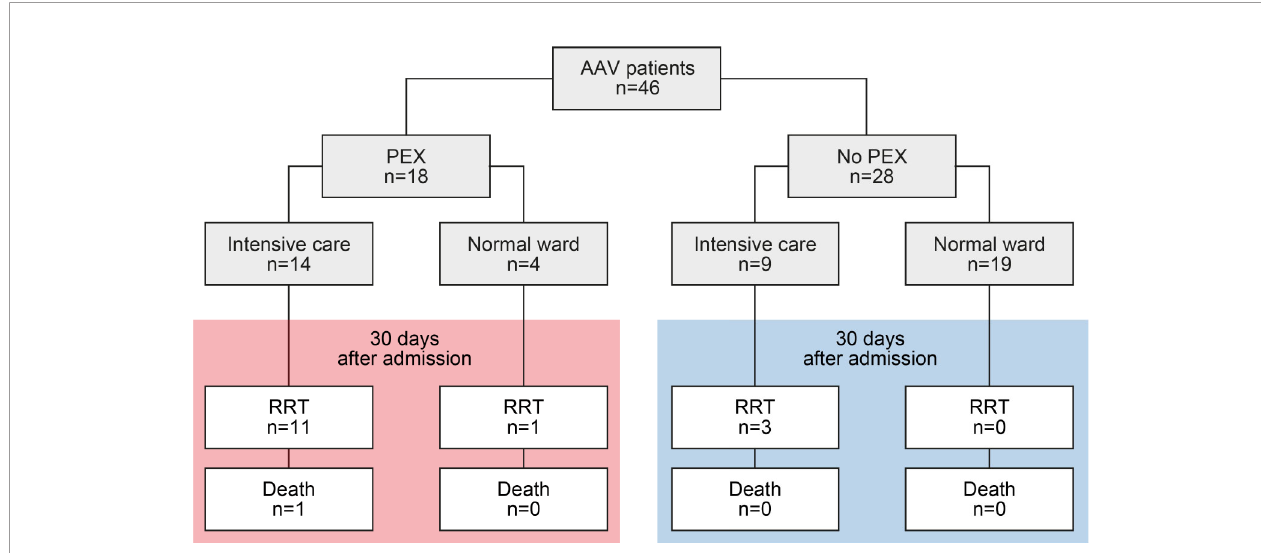
FIGURE 1 | Total patient cohort of severe AAV. STROBE fl ow chart of patient disposition, RRT was performed intermittently in all cases. AAV, ANCA-associated vasculitis; STROBE, Strengthening the Reporting of Observational Studies in